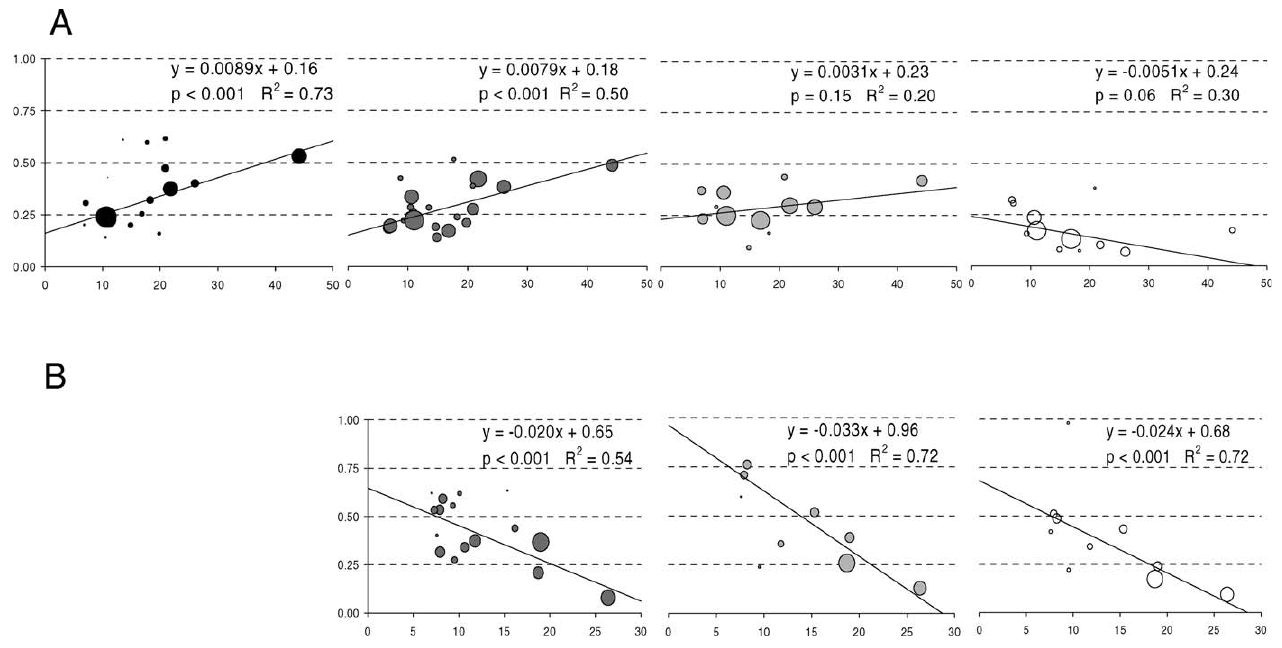
Figure 2. Sensitivity Analysis to Assess the Presence of a Dose-Response Relationship in Age Groups Older (A) and Younger (B) than 65 y for (from Left to Right) Mortality [(A) only], Hospitalizations, ED Use, and Doctors’ Office Visits The vertical axis represents the age group-, province-, and outcome-specific post- versus pre-2000 RRs. The horizontal axis represents the absolute post- versus pre-2000 change in influenza vaccination rates (%). The bubble sizes represent the inverse of the variances of the post- versus pre-2000 RRs. The p- values correspond to the significance of the estimates for the slope of the lines from weighted linear regression models ( t- tests). doi:10.1371/journal.pmed.0050211.g002 horizontal axis represents time. The solid black line represents observed hospitalizations, the dashed black line represents baseline hospitalizations in the hypothetical absence of influenza, and the black vertical bars represent influenza-associated hospitalizations (observed hospitalizations minus baseline hospitalizations). Viral surveillance data (grey shaded areas) are expressed as the weekly percentage of tests positive on the right vertical axis. The grey dashed vertical lines denote periods of peak influenza activity. Table S1. Duration of Periods of Peak Influenza Activity, Influenza A(H3N2) Predominance, and Vaccine Antigenic Mismatch between Circulating and Vaccine Strains, by Influenza Season and Province Table S2. Analysis to Evaluate the Presence of Influential Provinces by Removing Them Individually from the Model Found at doi:10.1371/journal.pmed.0050211.st002 (74 KB DOC).